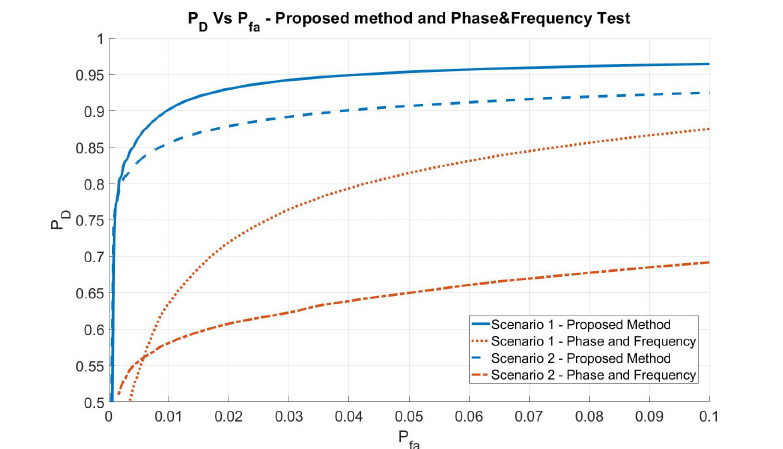
Figure 8. Comparison of the proposed method performance with the performance obtained by the method proposed in [31].